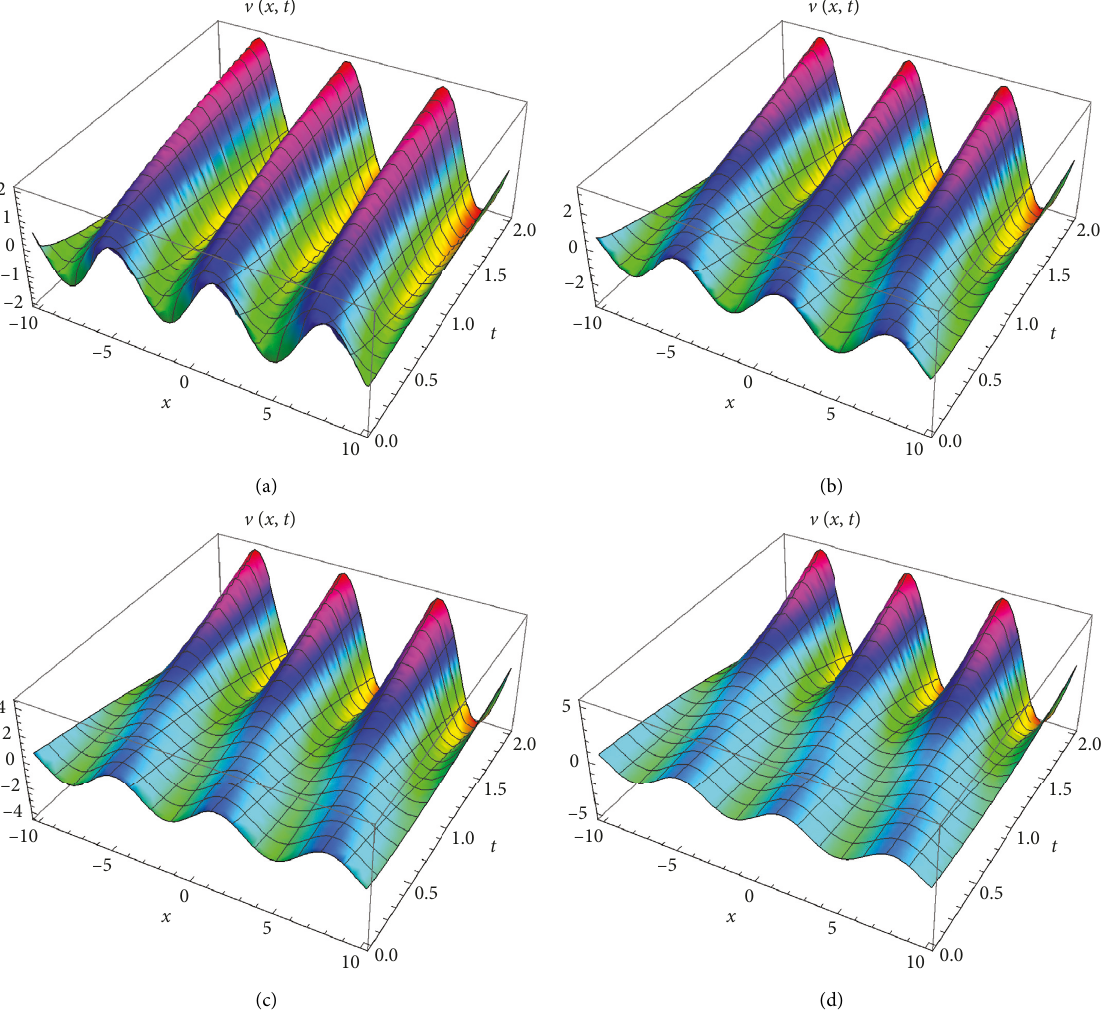
Figure 3: Surfaces plots for imaginary part of v ( x,t ) for distinct values of α . (a) Numerical simulation of v ( x,t ) when α � 0 . 25. (b) Numerical simulation of v ( x,t ) when α � 0 . 50. (c) Numerical simulation of v ( x,t ) when α � 0 . 75. (d) Numerical simulation of v ( x, t ) when α �